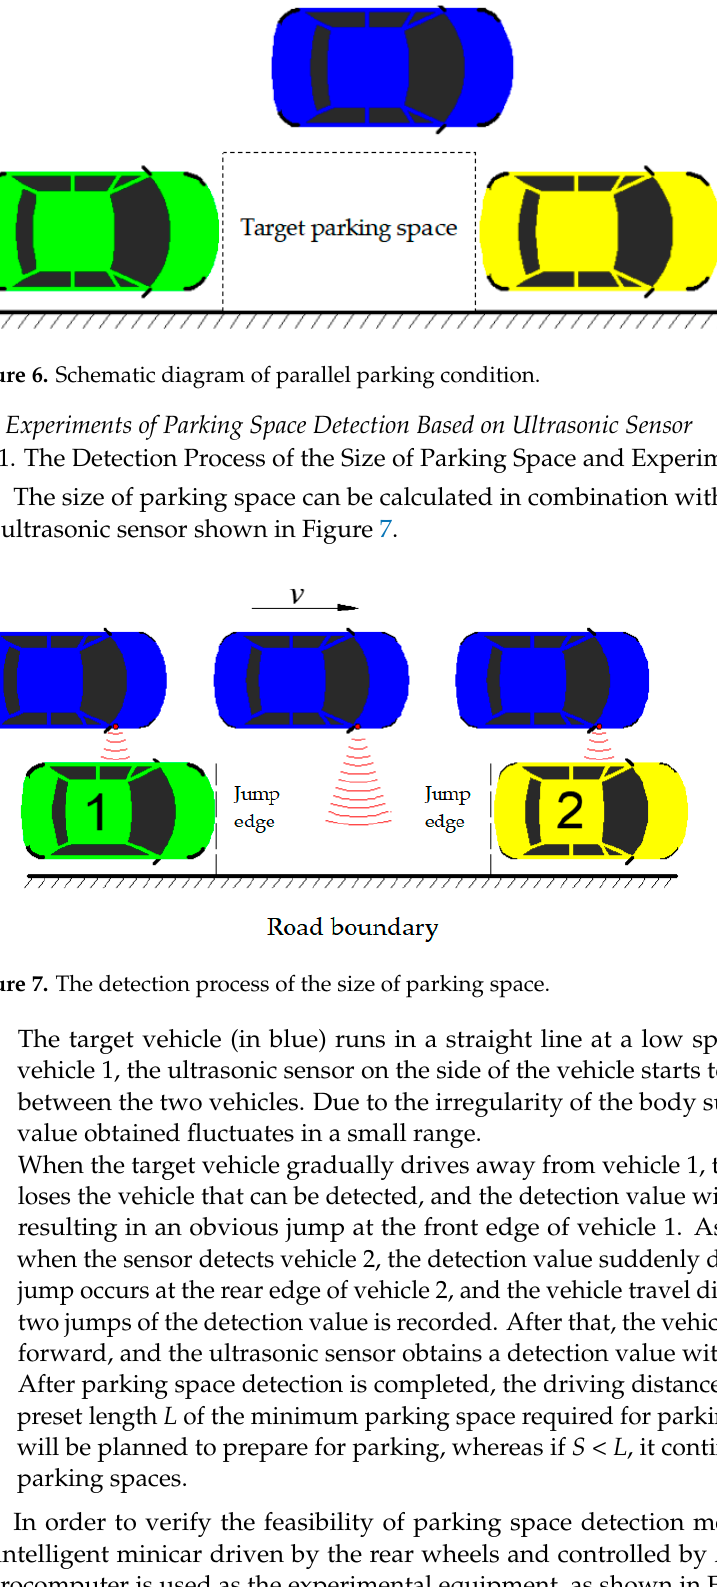
Figure 6. Schematic diagram of parallel parking condition.